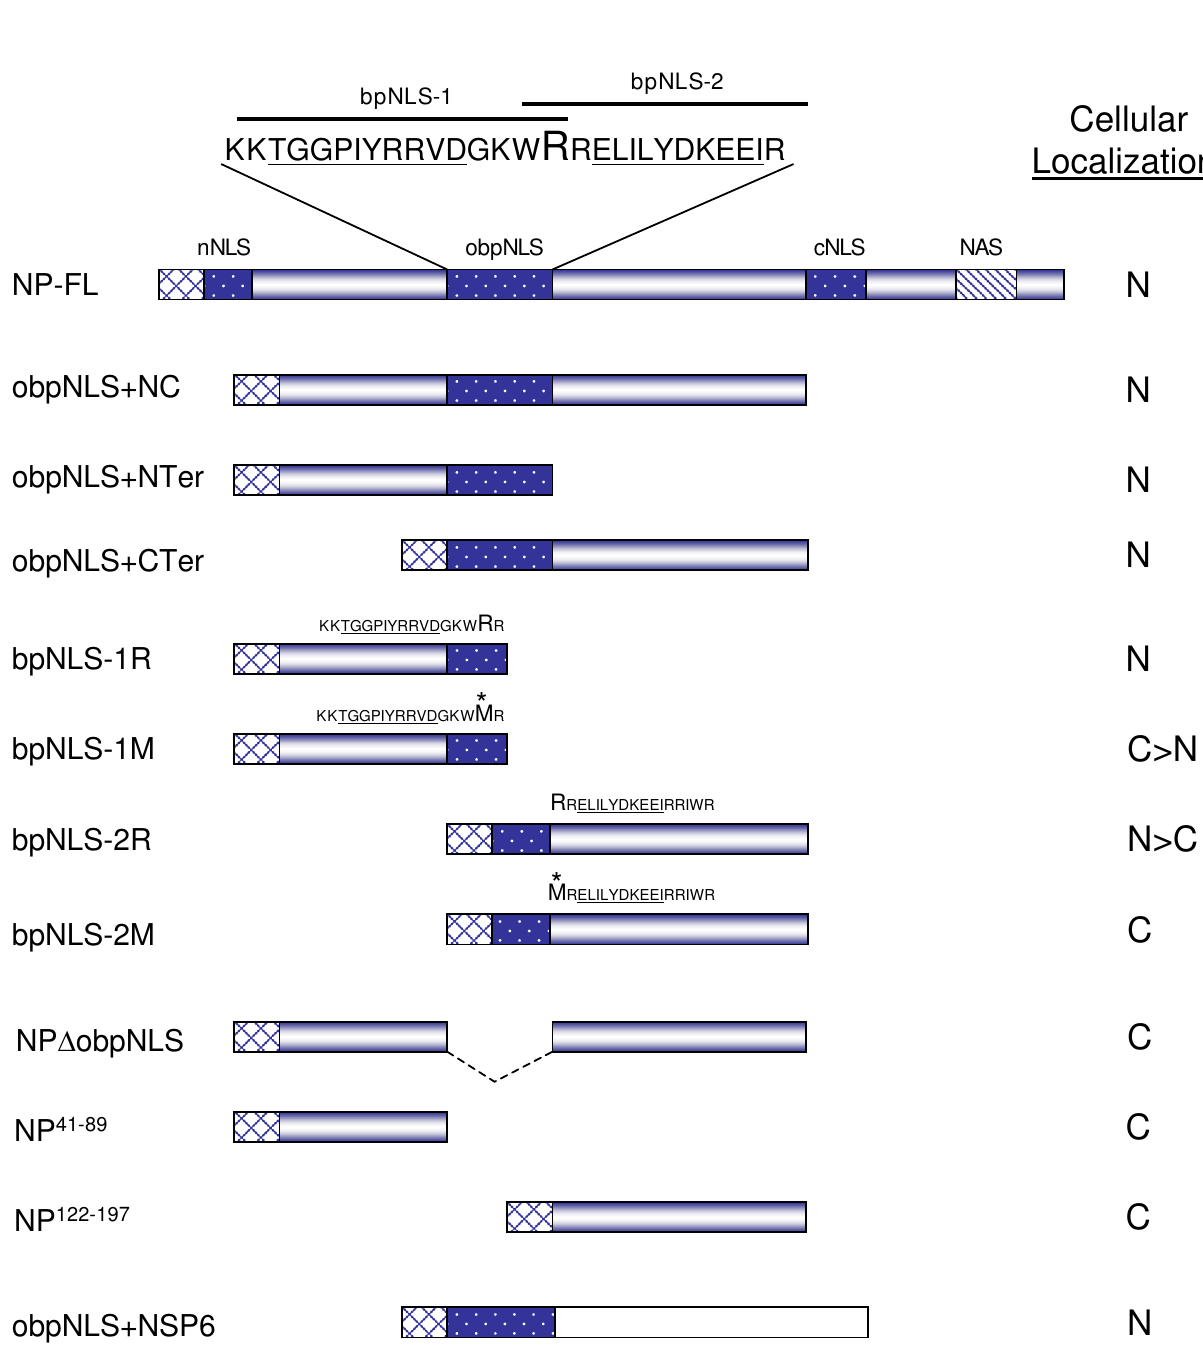
Figure 3 Schematic representation of NP-full-length and deletion constructs. Various NP-FL and deletion clones were made between the nNLS and cNLS regions. GFP is represented by chequered-box; NLS regions are indicated by darkly-shaded box; nuclear accumulation signal (NAS) is indicated by striped-box; rotavirus NSP6 is represented by an empty, unshaded box. Crit- ical amino acid (R or M) at position 105 is indicated by larger font size and an asterisk. Cellular localization of each construct is indicated by N (nuclear), N>C (nuclear greater than cytoplasm), C>N (cytoplasm greater than nuclear), and C